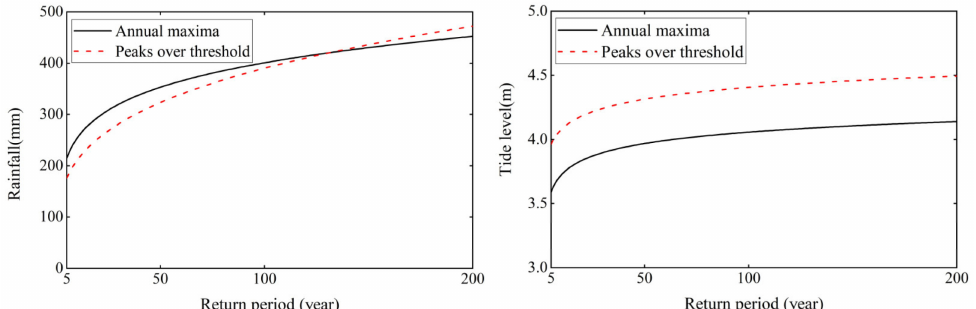
Figure 5. Comparison of the design rainfall and tide level of the two sampling